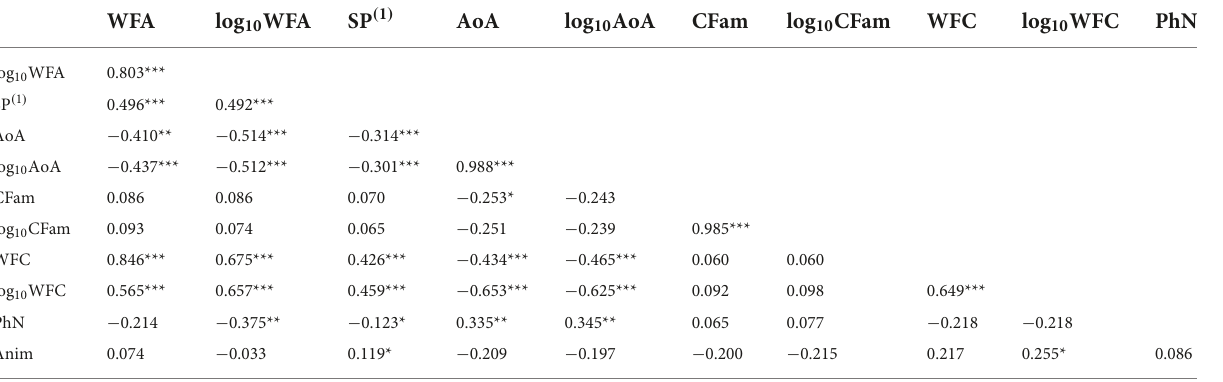
TABLE 1 Pairwise correlations between the word descriptors considered in Experiment